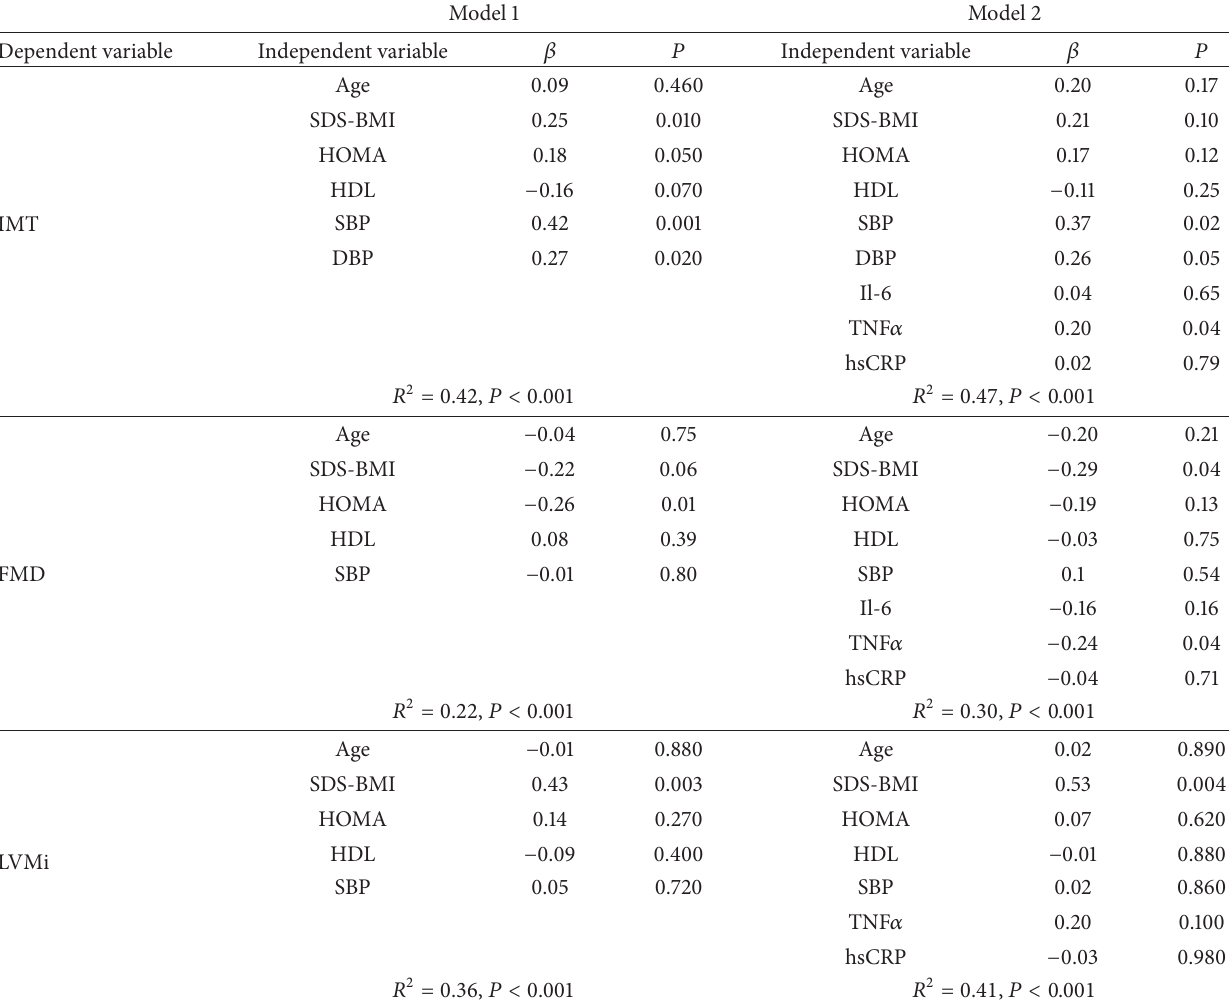
Table 6: Multiple linear regression analyses for IMT, FMD, and LVMi as dependent